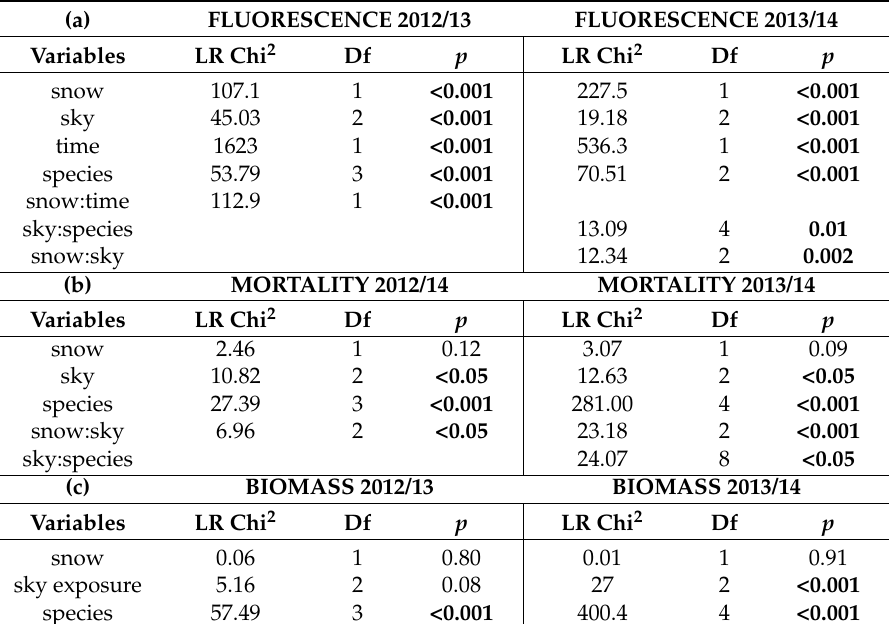
Table 1. Analysis of deviance of the generalized linear models (GLM) assessing the effect of snowmelt timing and sky-exposure treatments (‘snow’ and ‘sky’) on tree seedlings planted in 2012 (left column) and 2013 (right column) near the treeline in the French Alps. Response variables: ( a ) Fluorescence parameter Fv/Fm measured twice, shortly after snowmelt and in summer in 2013 (left), and one and 2.5 weeks after snowmelt in 2014 (right). ‘Time’ represents the two measurement times in each year. ( b ) Final mortality in August 2014. ( c ) Biomass after one growing season. LR Chi 2 = likelihood ratio test, Df = degrees of freedom.